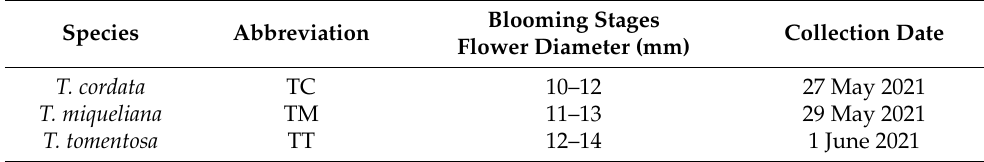
Table 1. Basic situation of plant materials selected from the three species.